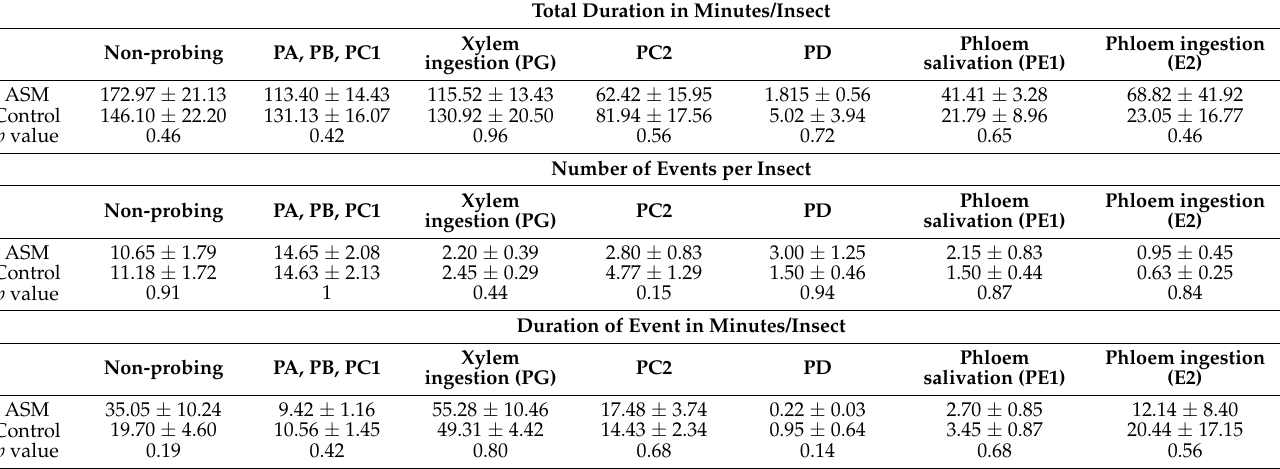
Table 4. Comparison of EPG-DC waveforms (mean time in minutes ± standard error of the mean, SEM, or mean number of events ± SEM) (8 h of recording) of C. pyri winter adults ( n = 20 on ASM, n = 22 control) feeding on ASM- or water- (control) treated pear plants. Waveforms were classified according to [29–31].